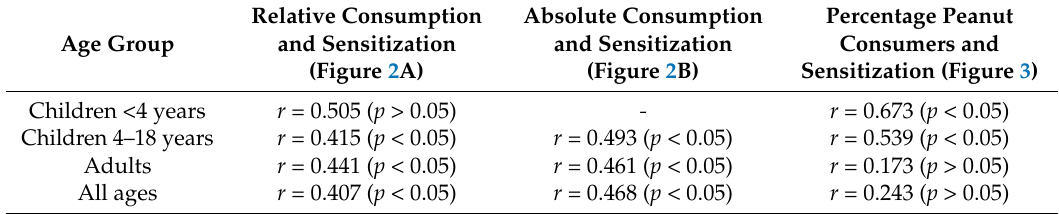
Table 1. Correlation ( r values) for relative and absolute consumption with sensitization and percentage of peanut consumers with sensitization using WLS linear regression analysis.